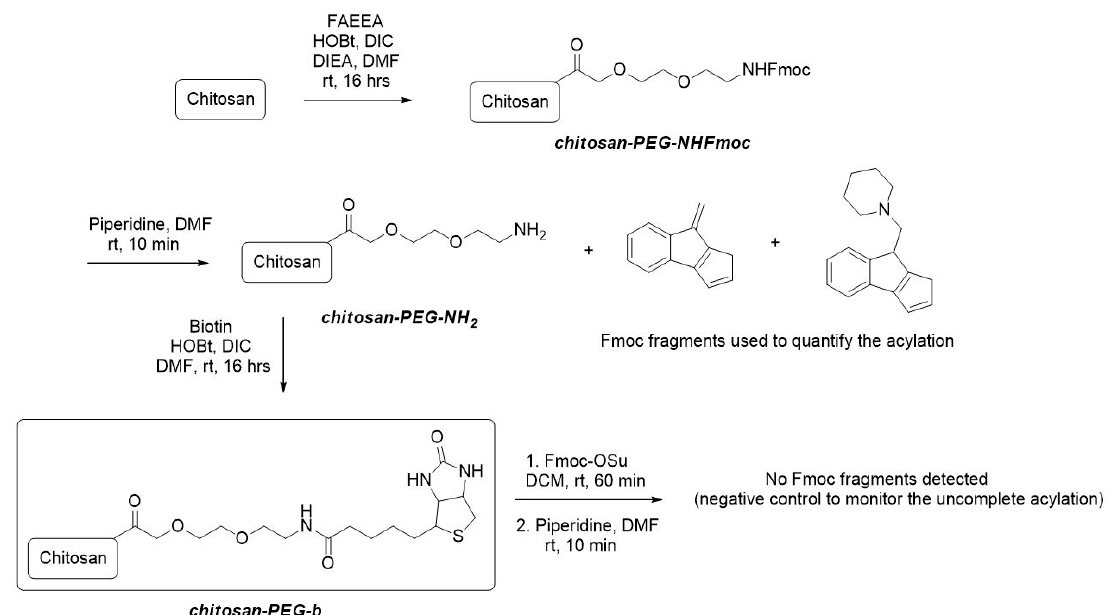
Figure 1. Synthetic approach to obtain the modified chitosan (chit-PEGb system).